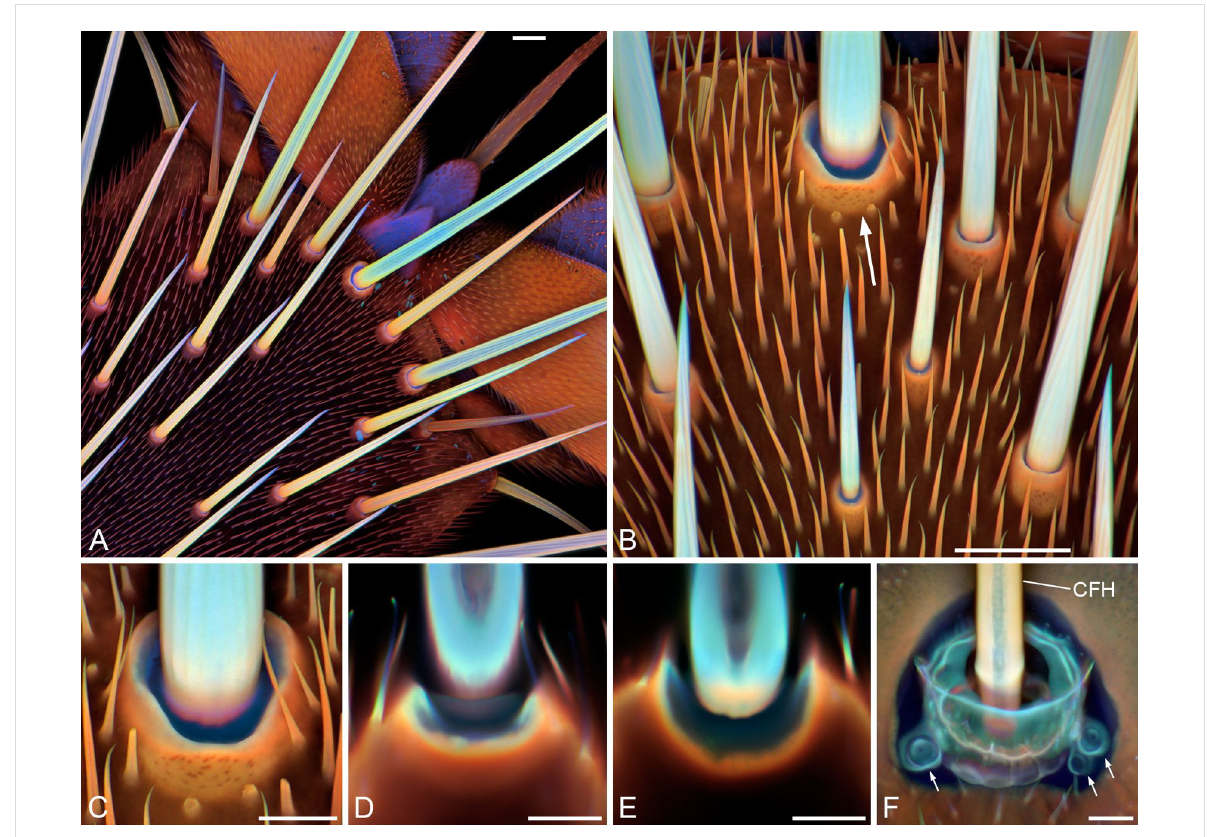
Figure 9: Resilin in mechanoreceptors. (A–F) Confocal laser scanning micrographs showing overlays of different autofluorescences exhibited by the exoskeletons. Blue colours indicate large proportions of resilin. (A) Dorsal view of the pretarsus of a third leg of a female drone fly ( Eristalis tenax ). (B) Dorsal view of a section of a second leg’s pretarsus of a male E. tenax . The arrow highlights a hair plate sensillum. (C) Larger view of the hair plate sensillum highlighted in B. (D, E) Confocal laser scanning micrographs showing 1 µm thick optical sections through the hair plate sensillum shown in C. (F) Cercal filiform hair (CFH) and associated campaniform sensilla (highlighted by small arrows) on a cercus of a female house cricket ( Acheta domesticus ). (A–C, F) Maximum intensity projections. Scale bars = 25 µm (A, B), 10 µm (C–F). Figure reproduced with permission from [10], copyright 2011 John Wiley and